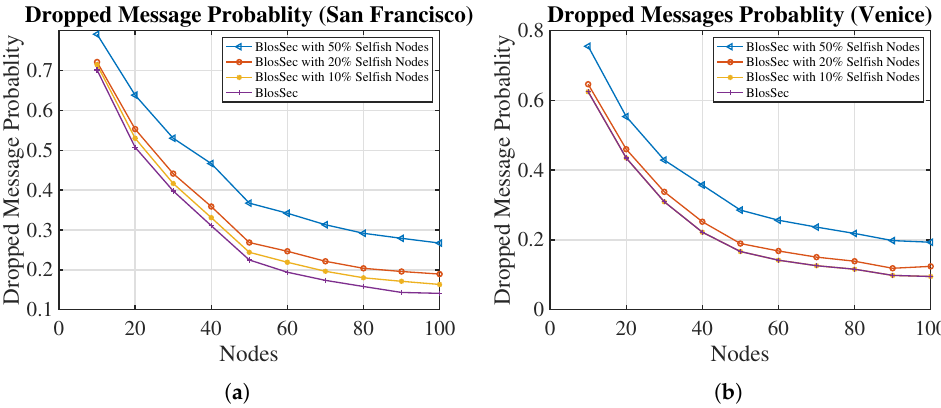
Figure 11. Comparison of the dropped messages probability of BlosSec in networks with selfish nodes dropping 20% of their messages. ( a ) San Francisco; ( b )